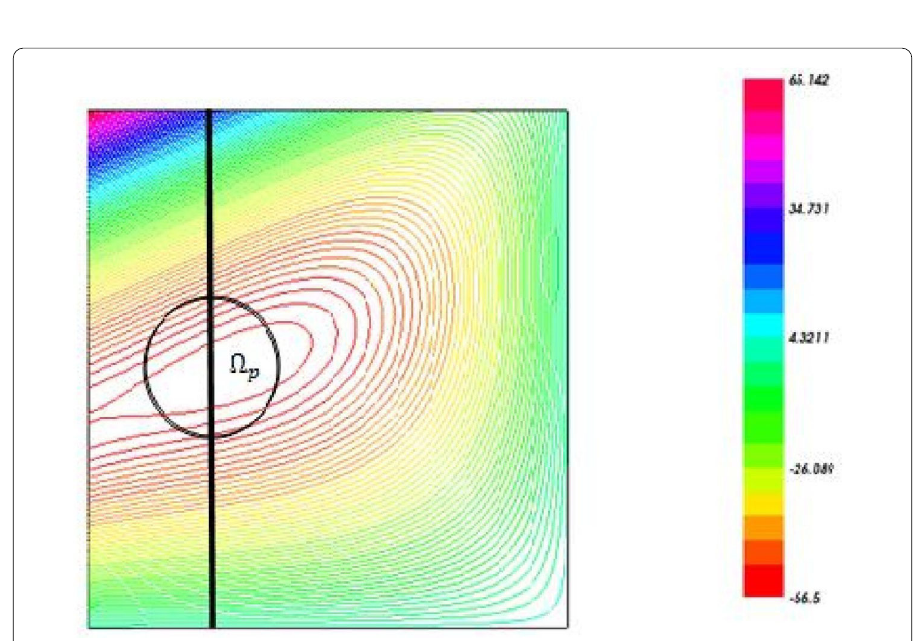
- The Dirichlet and Neumann boundary data are given